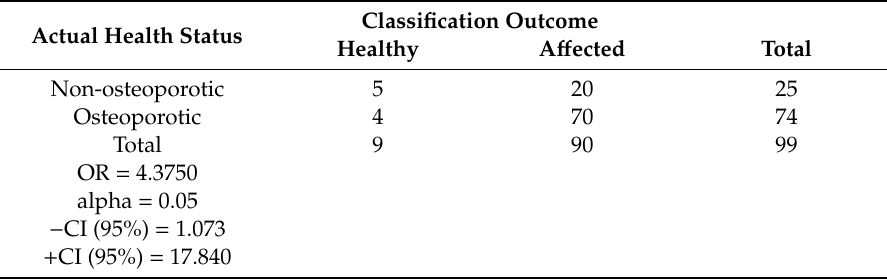
OR—odds ratio; CI—confidence interval.